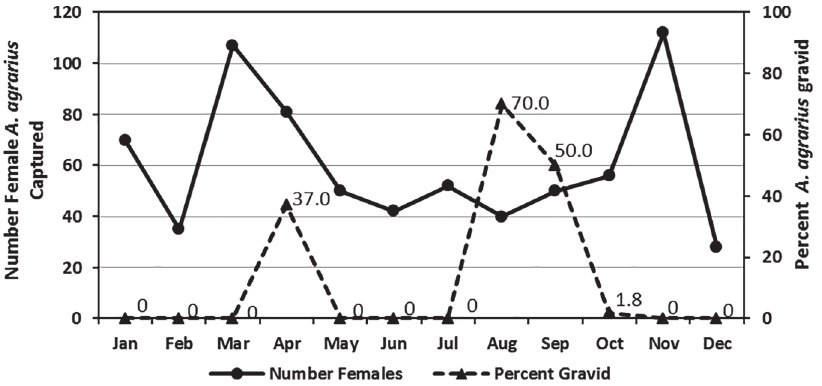
Fig 2. Number of Apodemus agrarius females captured monthly and percent gravid at Nightmare Range from January 2008-December 2009.